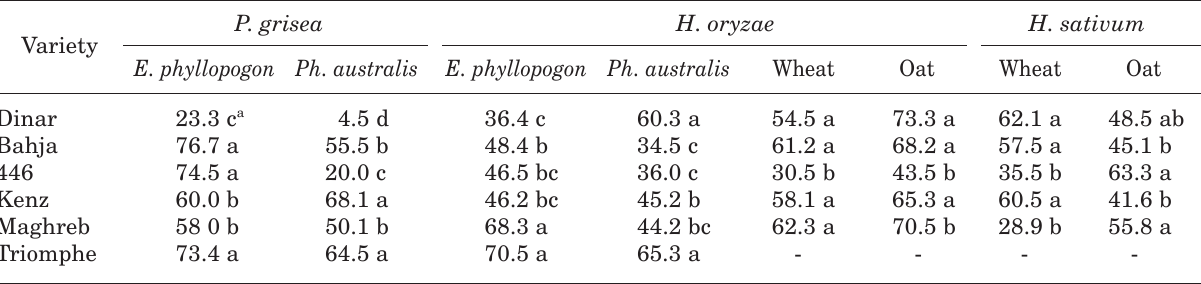
Table 2. Severity indexes of Pyricularia grisea , Helminthosporium oryzae and H. sativum isolated from wheat, oat, Echinochloa phyllopogon and Phragmites australis on the leaves of six rice varieties. The severity of infection was scored seven days after inoculation, according to the scale of Notteghem et al. (1980) for P. grisea and according to Barrault’s scale (1989) for H. oryzae and H.